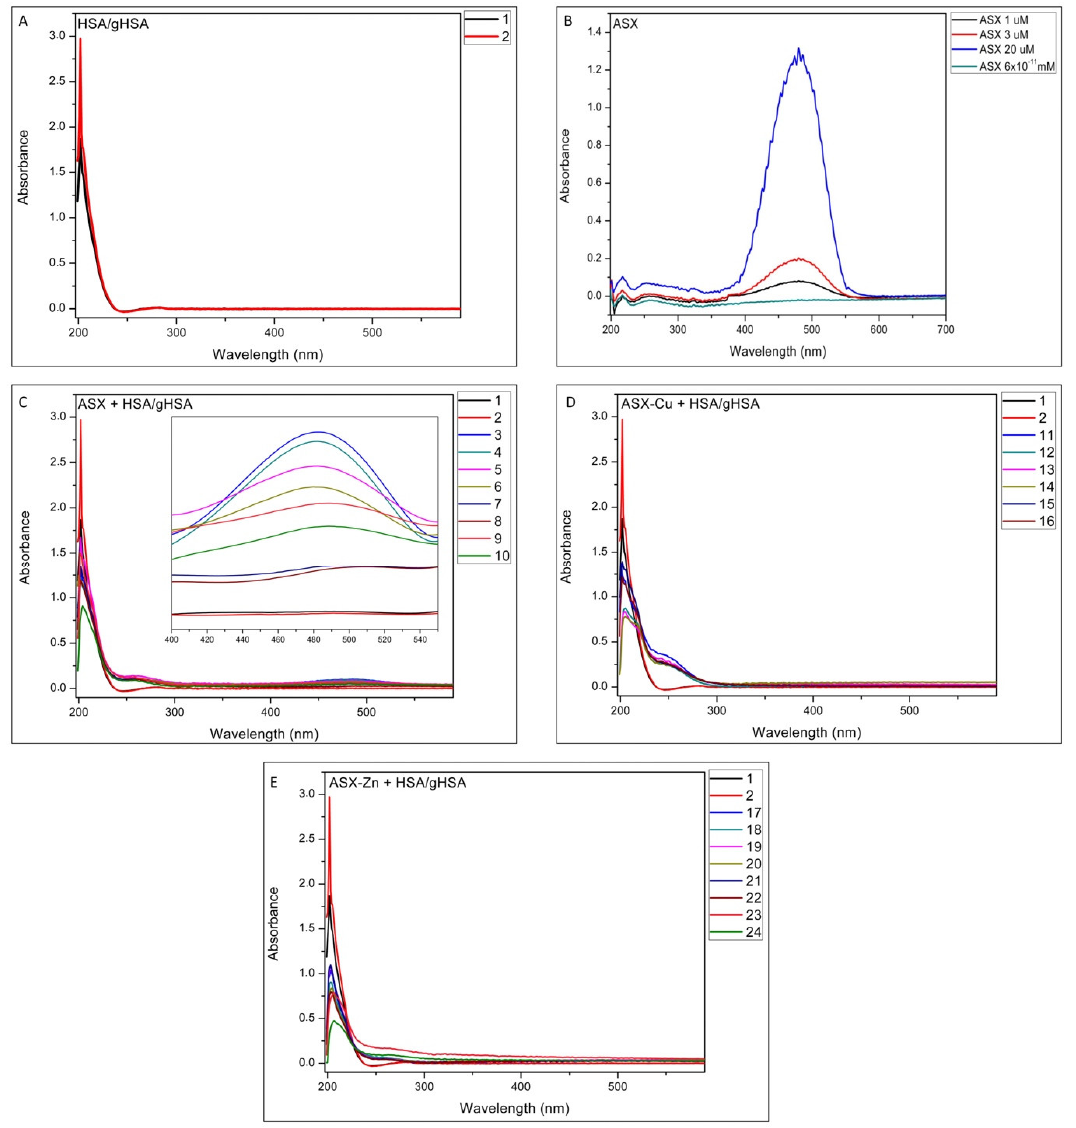
Figure 1. UV-Vis spectra of ( A ) HSA and gHSA; ( B ) ASX at different concentrations; ( C ) ASX complexed with HSA and gHSA using several molar ratios. The inset shows the absorbance peak variation in ASX in the range of 400–550 nm ( D ) ASX-Cu and HSA/gHSA complexes at different molar ratios and ( E ) ASX-Zn and HSA/gHSA complexes at different molar ratios. Sample codes are 1 (HSA 1 μM), 2 (gHSA 1 μM), 3 (gHSA-ASX 3 μM), 4 (HSA-ASX 3 μM), 5 (gHSA-ASX 20 μM), 6 (HSA-ASX 20 μM), 7 (gHSA-ASX 6 × 10 −11 mM), 8 (HSA-ASX 6 × 10 −11 mM), 9 (gHSA-ASX 1 μM), 10 (HSA-